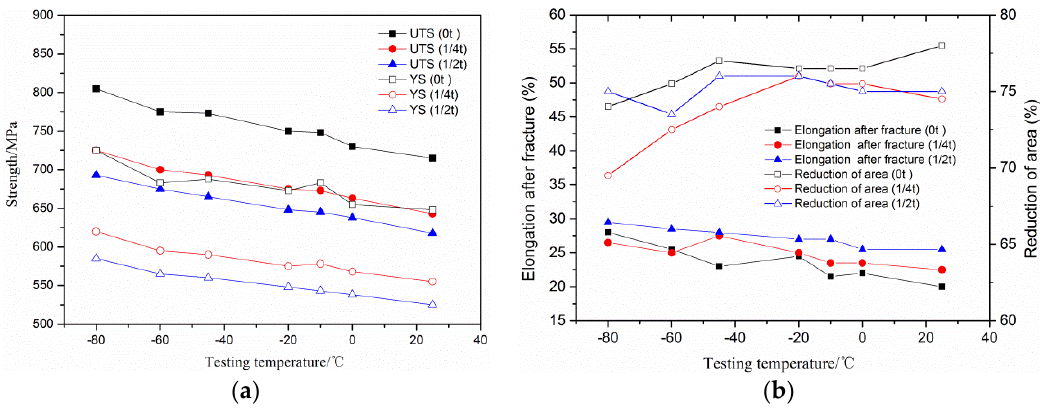
Figure 4. Tensile properties of 130 mm-thick steel plate at various temperatures. ( a ) ultimate tensile strength (UST) and yield strength (YS); ( b ) elongation after fracture and reduction of area.